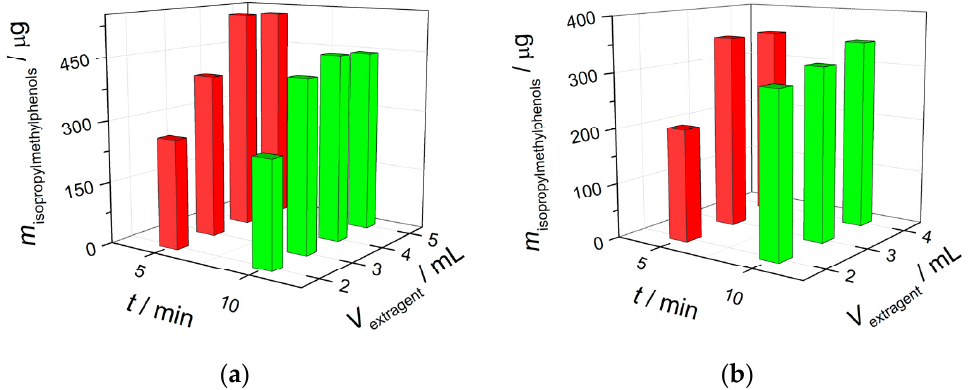
Figure 11. Isopropylmethylphenols extraction efficiency from spices: ( a ) oregano; ( b ) thyme. Data are based on the DPV for the extracts at the polythymolphthalein/MWCNTs/GCE in Britton–Robinson bu ff er pH 2.0.